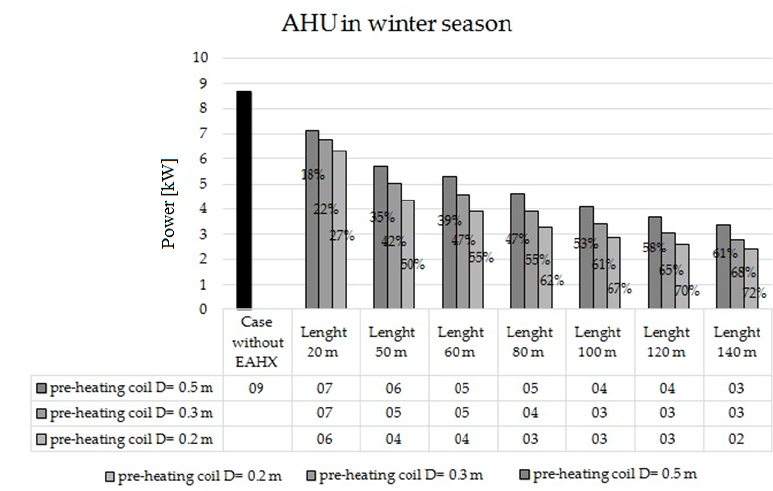
Figure 10. Power of pre-heating coil and relative percentage of reduction by varying diameter and length of buried tubes during winter.